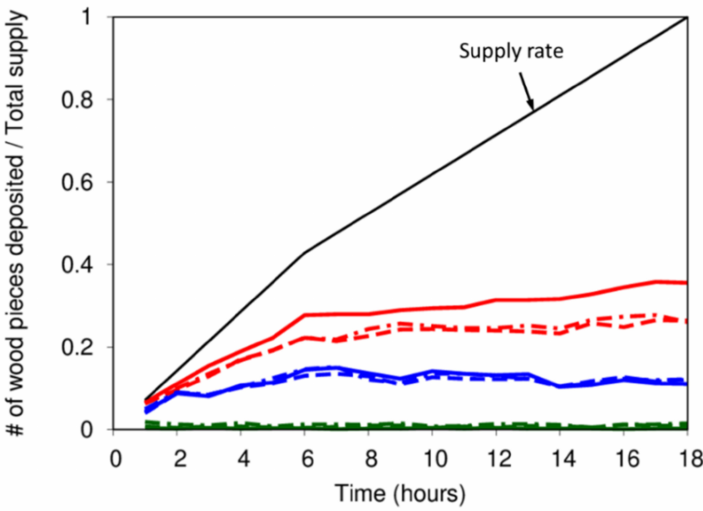
Figure 8. Temporal change in depositional rate of wood in numerical simulations. Red, blue, and green lines represent the results of cases 1, 2, and 4, respectively. Solid, dash, and dot-dash lines denote depositional rate of wood by different wood length, namely, values shown in Table 1, 3 cm, and 5 cm,